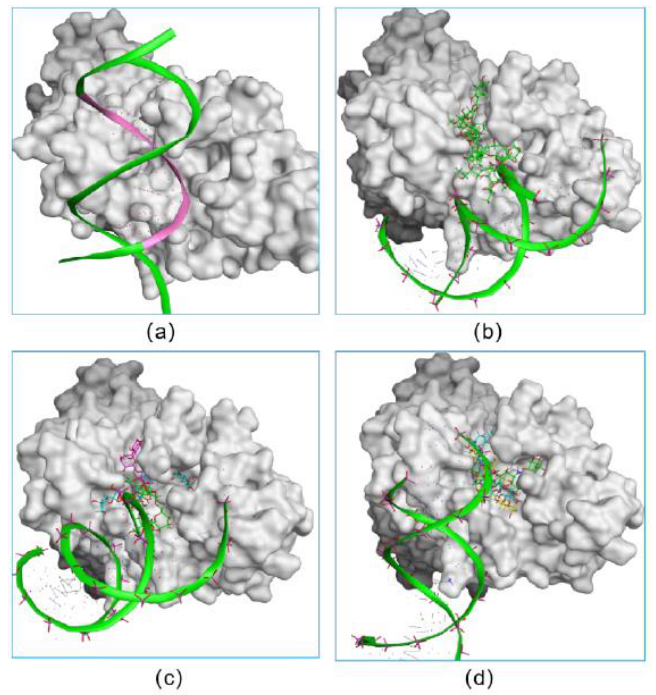
Figure 3. The verification on the abilities of small inhibitors to inhibit the formation of the NICD–MAML–RBPJ–DNA complex. The original DNA bound complex is shown ( a ). The occupancy of three fidaxomicin ( b ), four schaftoside ( c ) or three acarbose ( d ) molecules in the active site would inhibit the binding of DNA, indicating the DNA-competitive ability of the three hits.